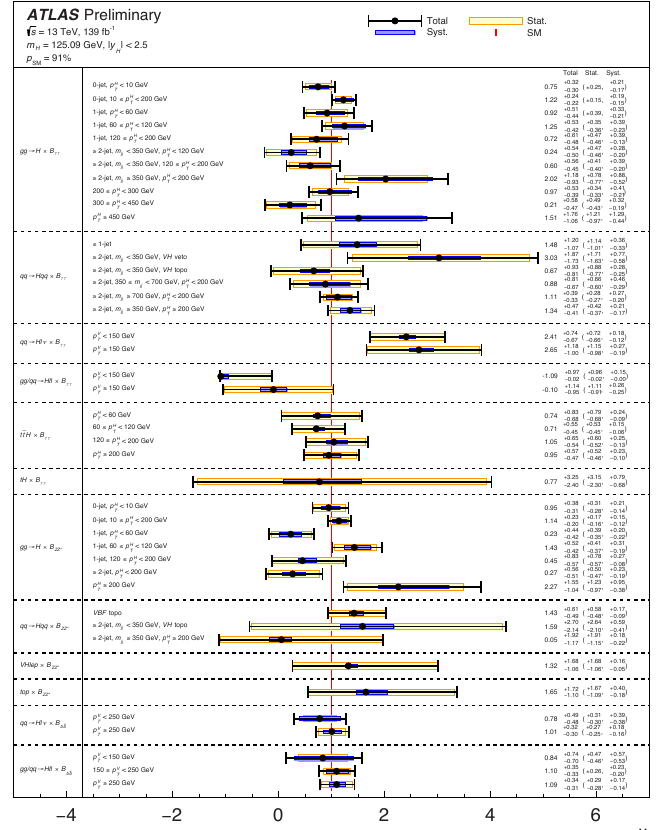
Figure 1: The ATLAS collaboration’s STXS measurements of g gF , V BF , V H and ttH production in the H → γγ and H → ZZ ∗ channel and V H production in the H → bb channel that enter in the statistical combination [ 15 ]